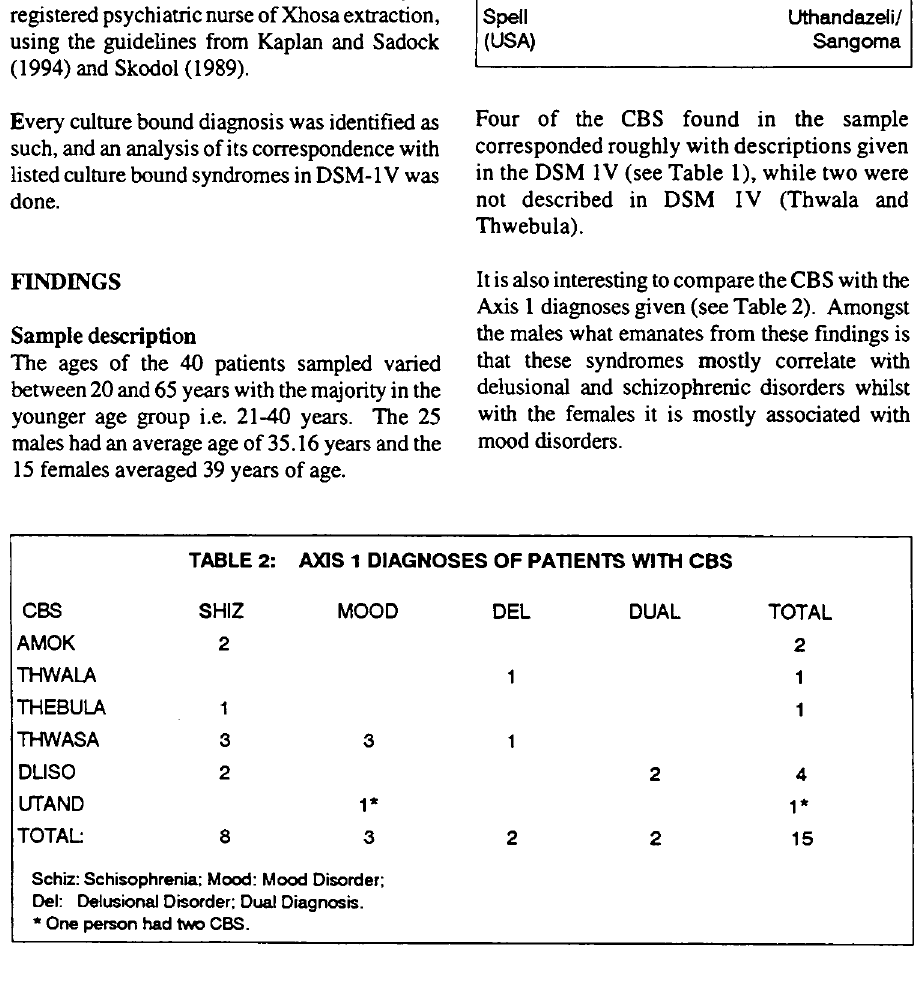
TABLE 2: AXIS 1 DIAGNOSES OF PATIENTS WITH